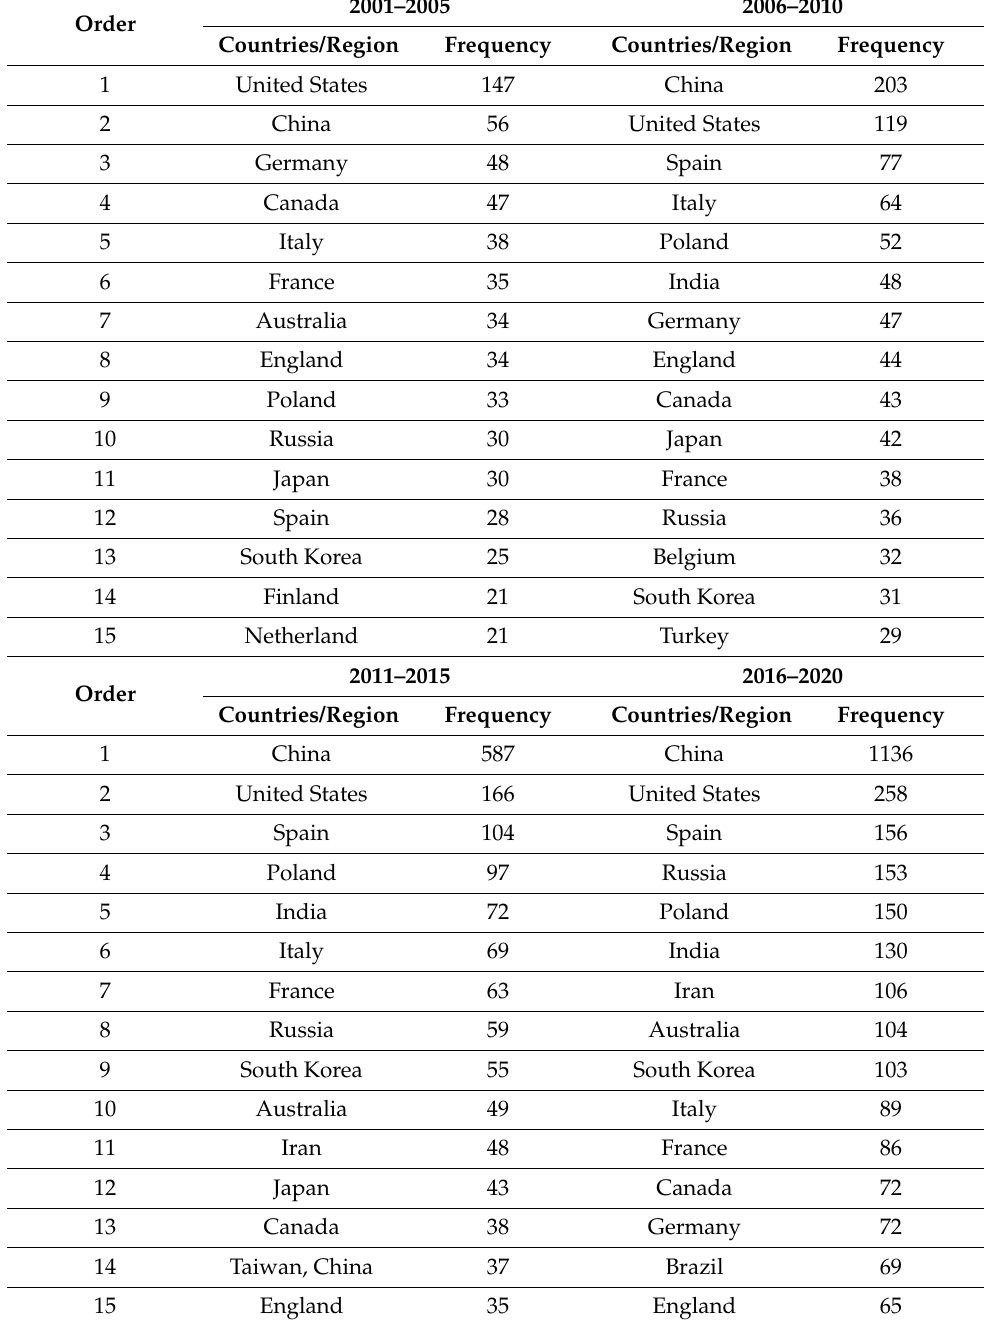
Table 1. Top 15 countries/region and frequency of papers